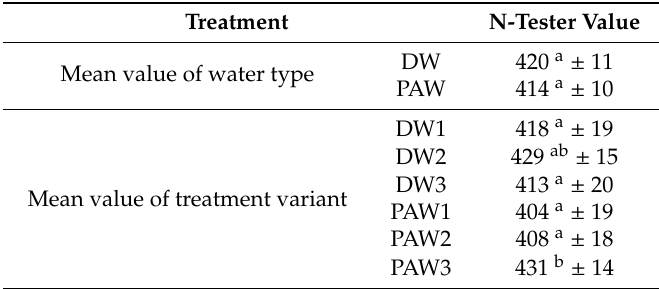
Table 3. The effect of plasma activated water (PAW) application on chlorophyll contents (N-tester value).